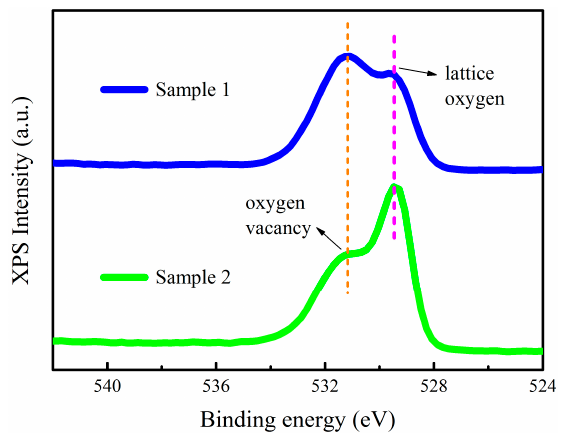
Figure 2. XPS spectra of the samples.